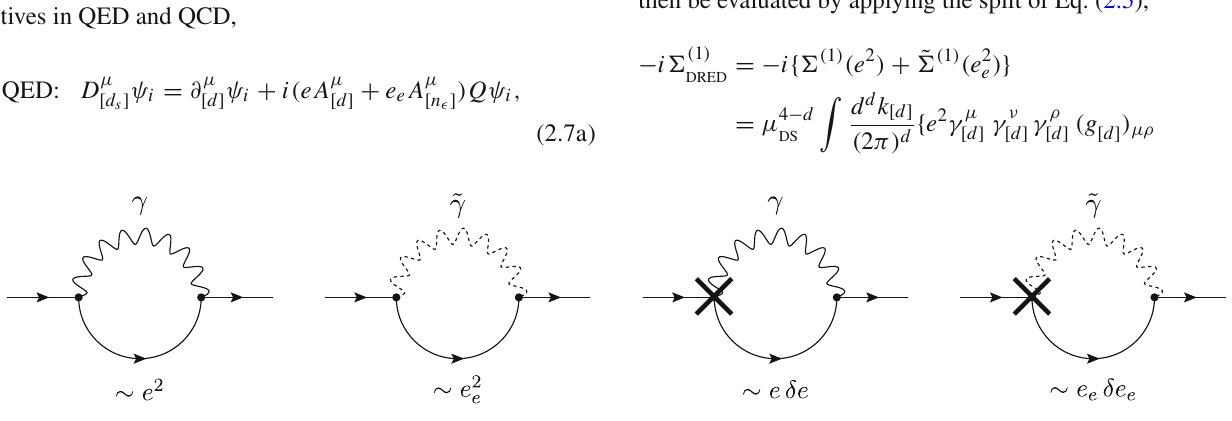
Fig. 1 Diagrams contributing to the electron self-energy at the one- and two-loop level including a quasi- d -dimensional photon ( solid wavy line ) and a quasi- n (cid:3) -dimensional (cid:3) -scalar ( dashed wavy line ), respec-